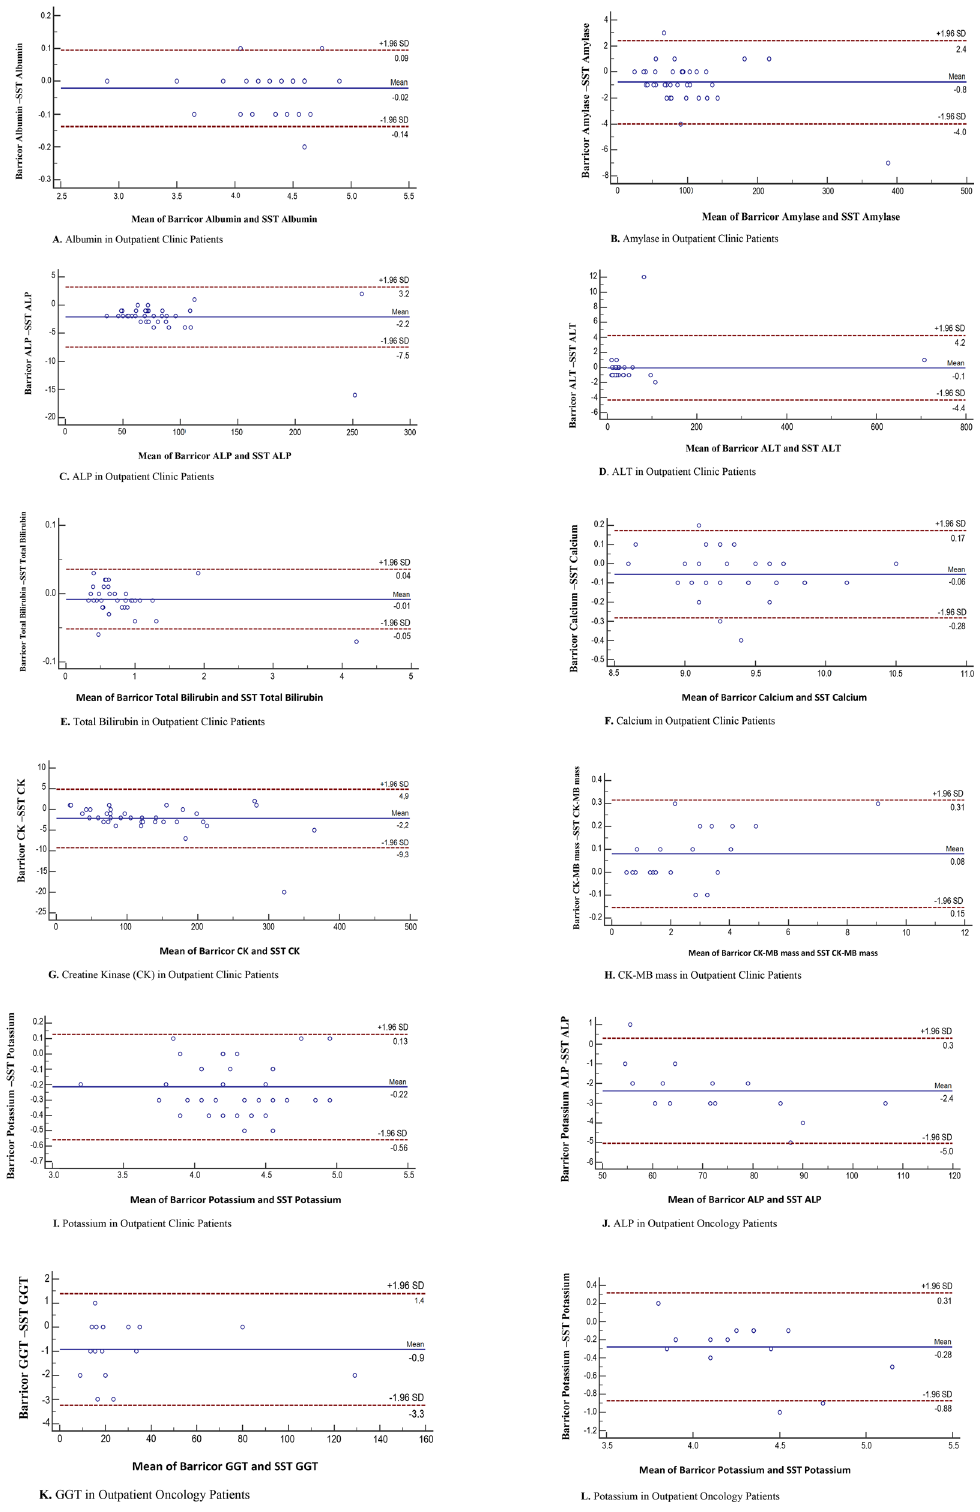
Figure 1: Bland – Altman plots for parameters with significant